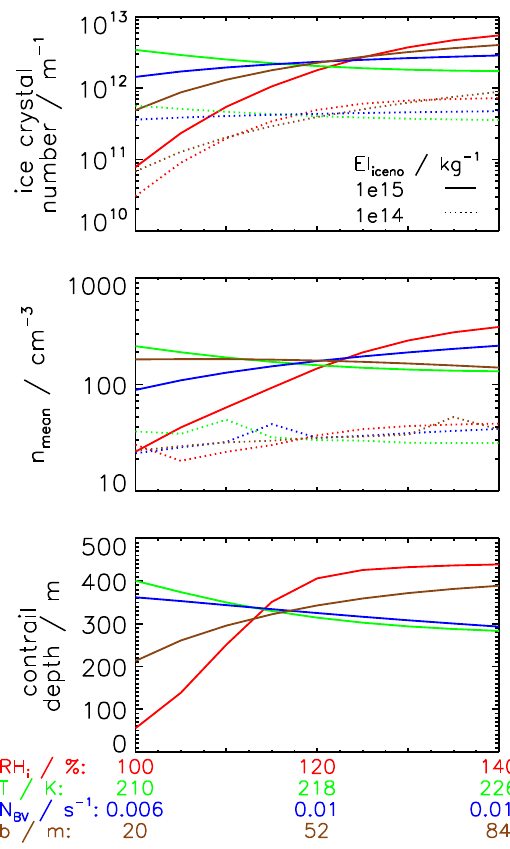
Figure 10. Ice crystal number per metre of flight path (top), mean ice crystal number concentration (middle) and contrail depth (bot- tom) after the vortex phase as a function of RH i , T , N BV or b . EI iceno is 10 15 or 10 14 kg − 1 . The contrail depth parametrisation does not depend on EI iceno